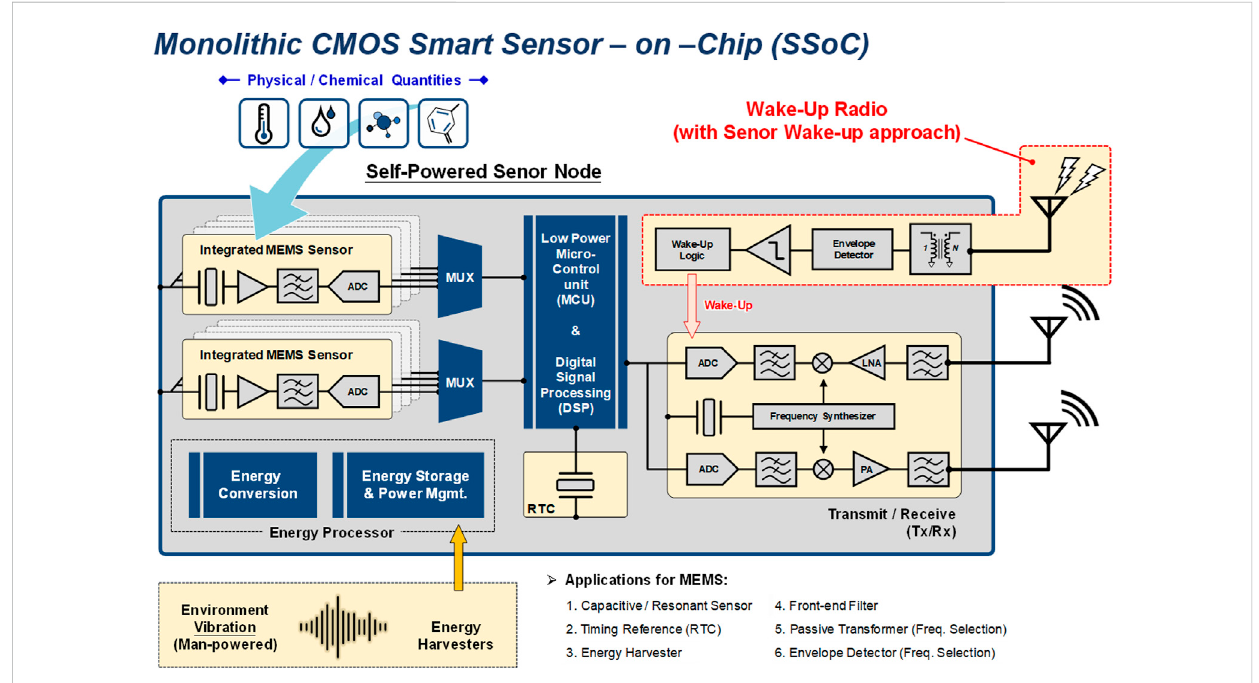
FIGURE 1 Conceptual CMOS-MEMS integration schematic of a monolithic Smart System-on-Chip (S-SoC) IC featuring MEMS sensors, actuators, and transceiver with signal processing